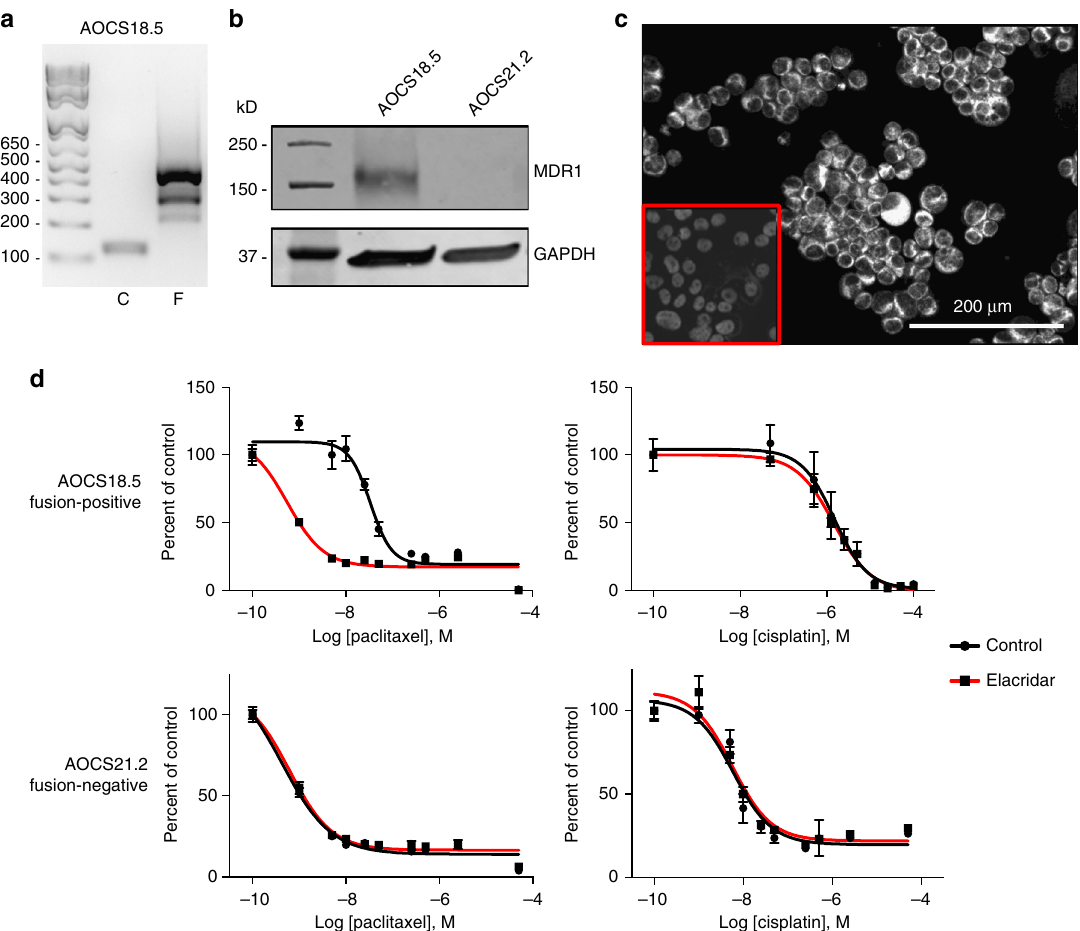
Fig. 4 Resensitisation of a fusion-positive cell line with an MDR1 inhibitor. a Fusion-speci fi c RT-PCR demonstrates that patient-derived cell line AOCS18.5 is positive for the SLC25A40 – ABCB1 fusion (F). C corresponds to RT-PCR using primers to measure ABCB1 expression. Ladder is shown in base pairs. b Western blot shows MDR1 expression in fusion-positive line AOCS18.5 but not in fusion-negative line AOCS21.2. c MDR1 expression in AOCS18.5 by immuno fl uorescence. Inset shows antibody isotype control. d IC50 plots in AOCS18.5 and non-fusion AOCS21.2 cell lines, showing a fusion-speci fi c increase in paclitaxel sensitivity, but sensitivity to non-substrate cisplatin, in the presence of the MDR1 inhibitor elacridar ( n = 3 replicates). Error bars indicate ± SEM. For some points, error bars are shorter than the height of the symbol and are not